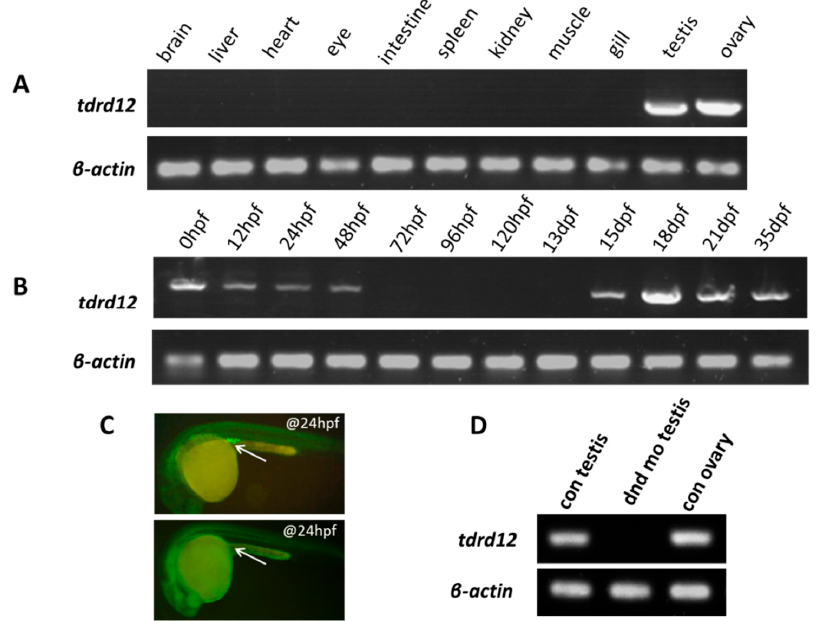
Figure 2. Maternal and germ cell-related expression patterns of tdrd12 . ( A ) Tissue distribution of endogenous tdrd12 transcripts with RT-PCR indicates its gonad-specific patterns in adult zebrafish; ( B ) The presence of endogenous tdrd12 transcripts at different developmental stages reveals its maternal expression pattern in unfertilized eggs. The expression of zebrafish tdrd12 is decreased in the early embryonic stage until the 48 hpf stage. The tdrd12 transcripts reappear from 15 dpf to the adult stage in the gonads; ( C ) Presence of PGCs visualized with injected EGFP- dnd 3’UTR mRNA in control larva ( upper panel , injected with control morpholino) and PGC-depleted larva ( lower panel , injected with dnd morpholino) at the 24-hpf stage. The arrowheads here show the presence of zebrafish PGCs in larva; and ( D ) Presence of tdrd12 transcripts detected in adult gonadal tissues of the control fish and PGC-depleted dnd morphants (no ovary). The transcripts of β -actin2 were amplified from the same templates as an internal control to check the quality of the